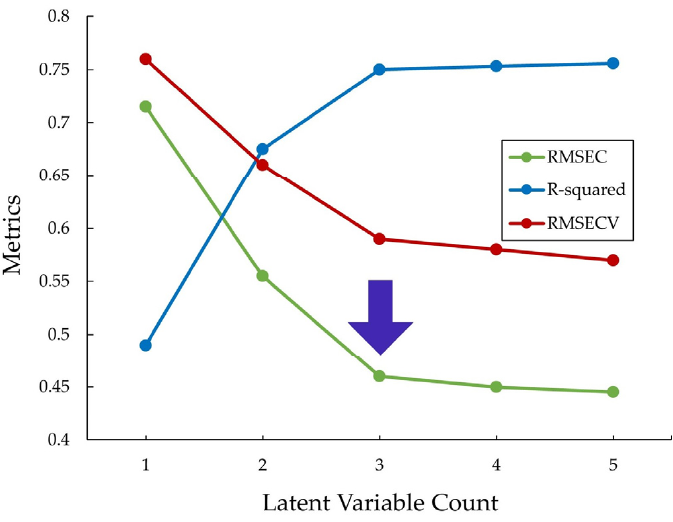
Figure 3. Plot for selection of optimal number of latent variables (LV) for PLSR model predicting mAb- δ complex afucosylation. The arrow indicates the point of stabilization for the RMSEC and RMSECV that was used to select the final number of LVs.